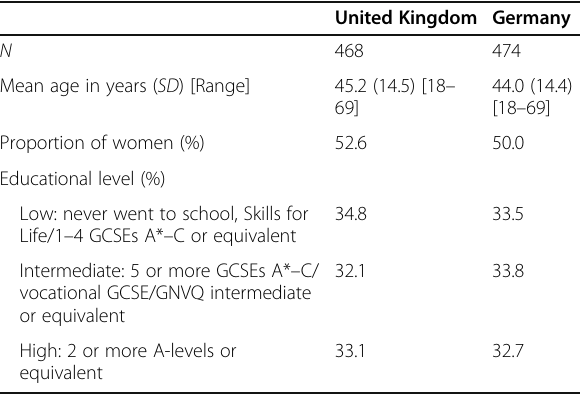
Table 2 Sample characteristics by